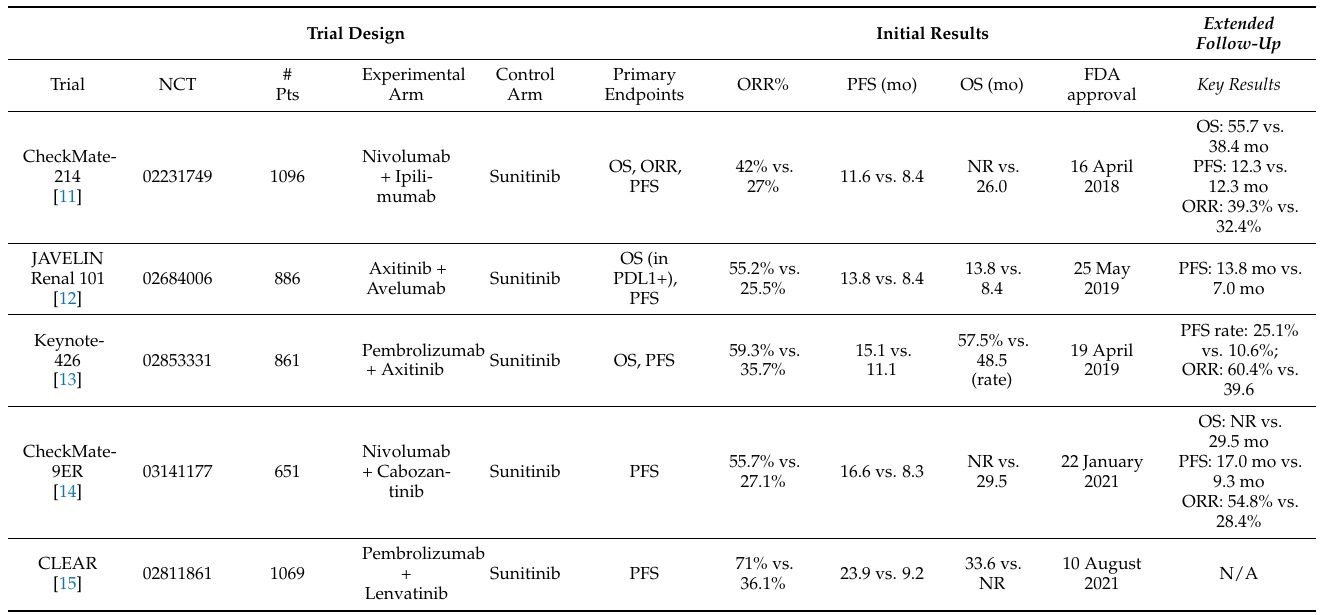
Table 1. Tabulation of first-line therapies in metastatic renal cell carcinoma with initial and follow- up results.